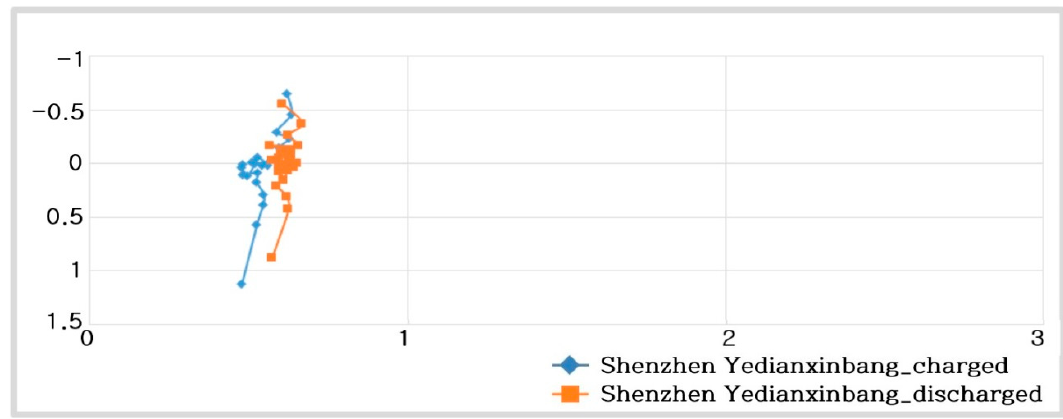
Figure 24. Impedance spectra of supercapacitor. The battery equivalent series resistance ( 𝑅 (cid:3020) ) values of the 18650-type cylindrical Li-ion batteries, without the protection device, during charging are as follows: